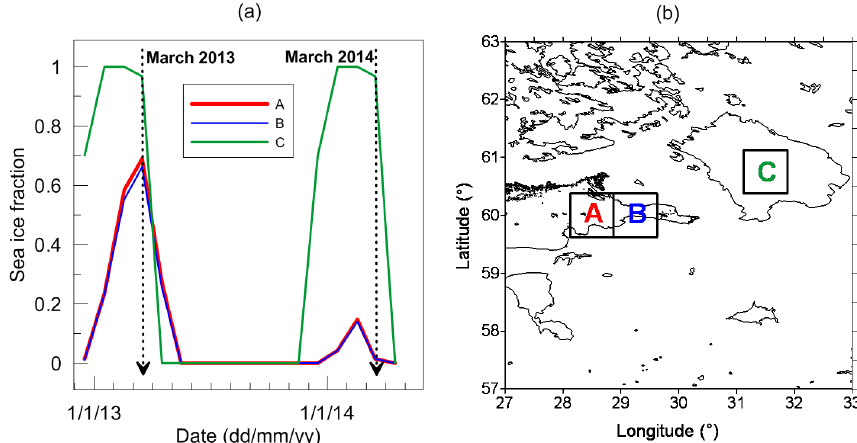
Figure 9. (a) The monthly mean values of the “sea ice area fraction” taken from the ECMWF reanalysis for three pixels close to the radiometer site and plotted for the period of observations considered in the present study. (b) Location of the three pixels, colours of numbers correspond to colours of lines in (a) . Vector shoreline data: GSHHG